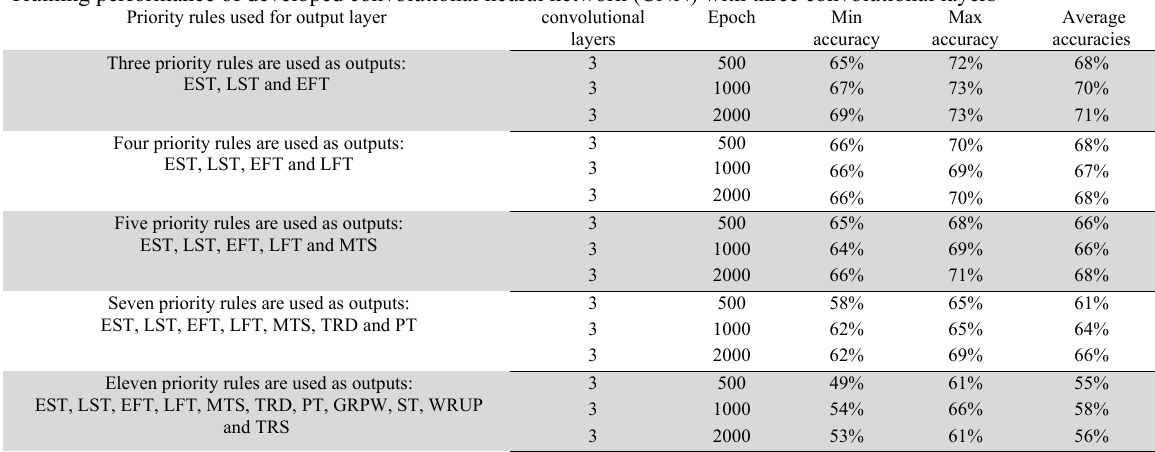
Epoch Min Max Average layers accuracy accuracy accuracies